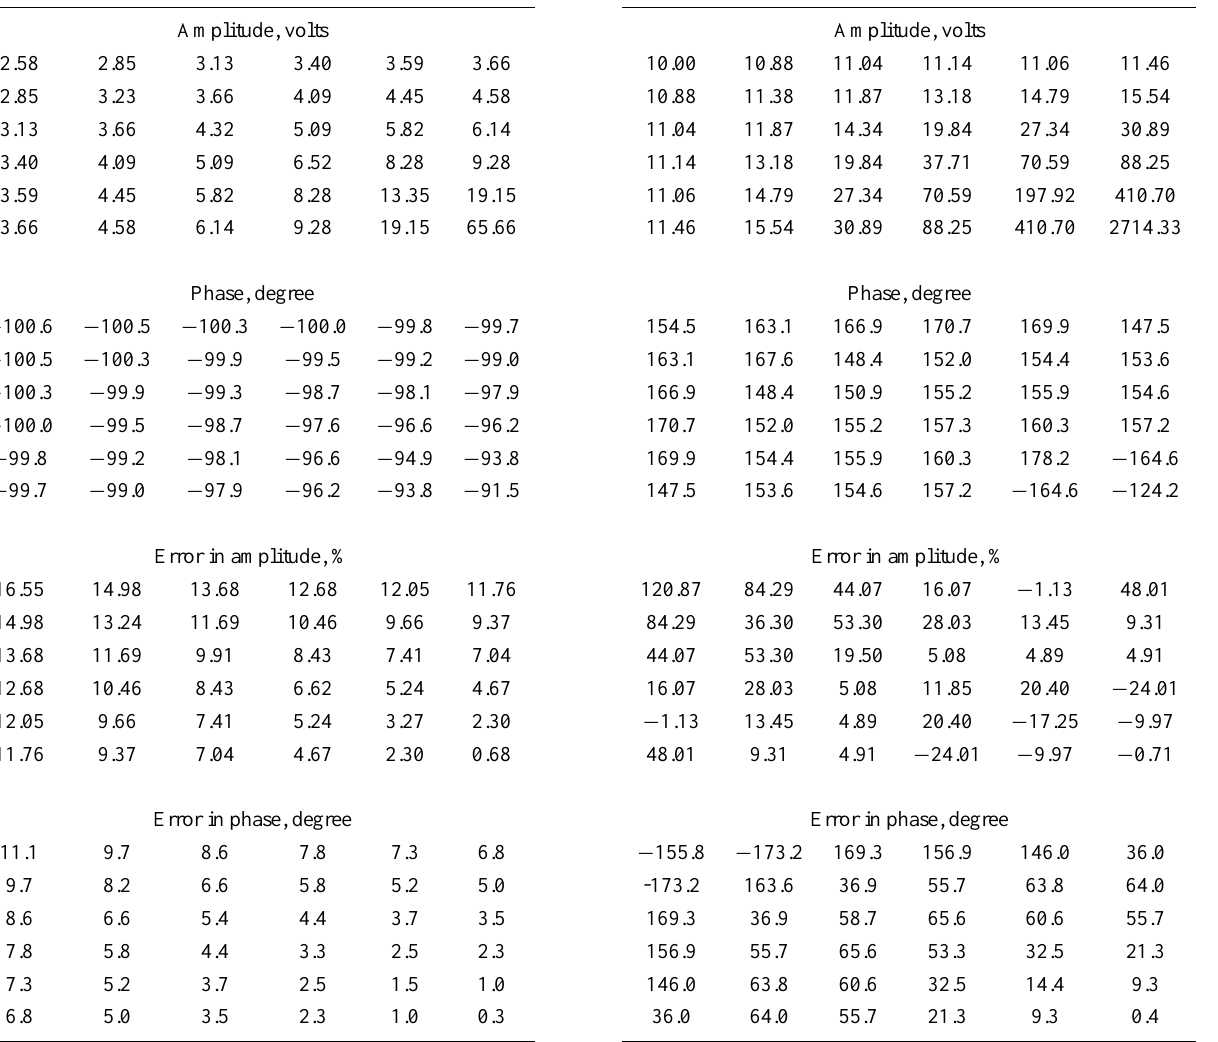
Table 1. Test case 1: low frequency, sparse grid. Table 2. Test case 2: high frequency, sparse